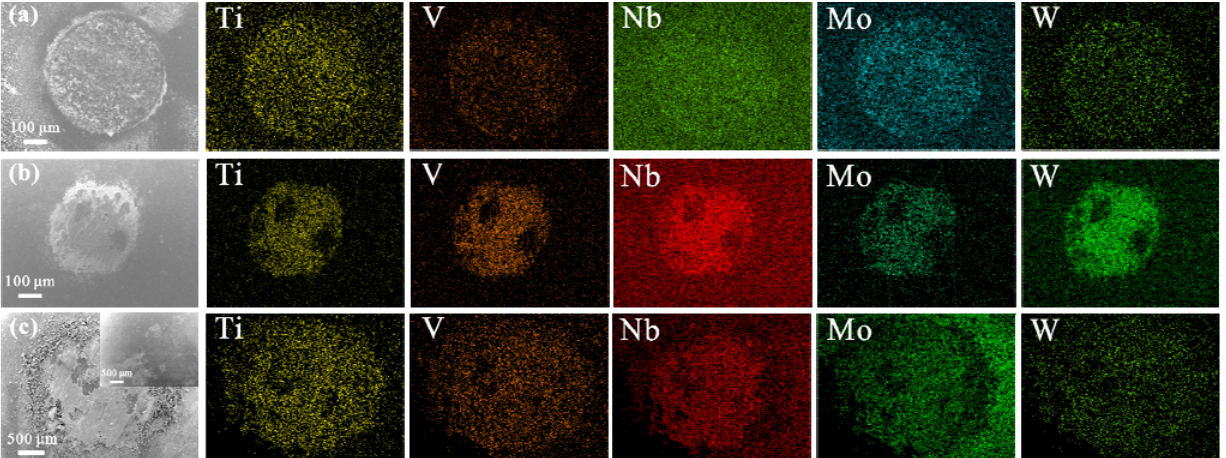
Fig. 16 Surface morphologies of Al 2 O 3 balls and corresponding EDS element distribution diagrams at (a) RT, (b) 400 ℃ , and (c) 800 ℃